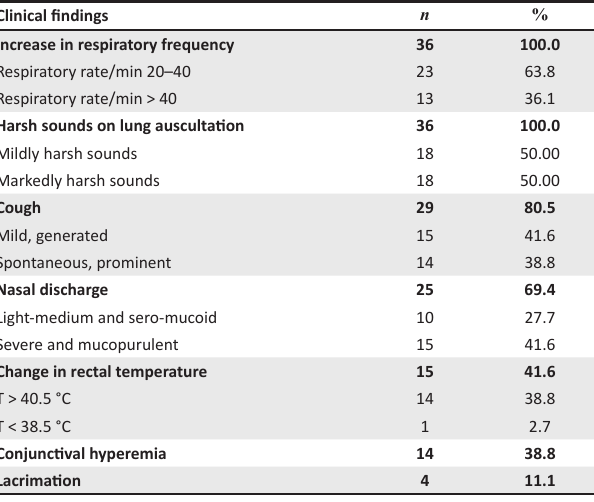
TABLE 2: Detected clinical findings in 36 goat kids.